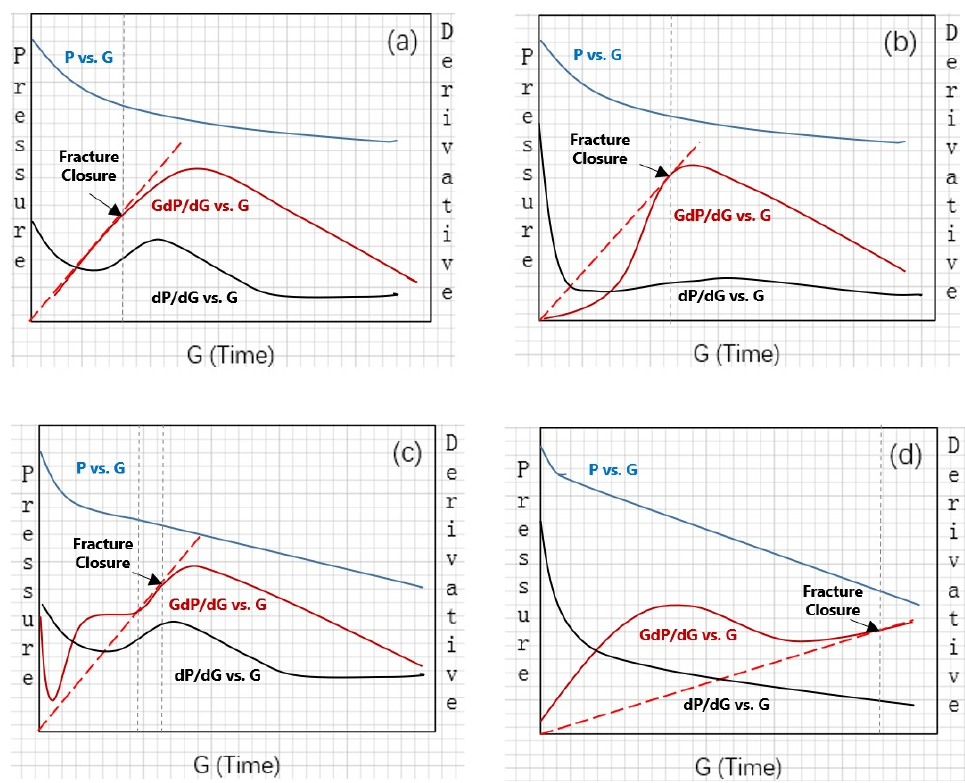
Figure 2. Type of pressure vs. G-function, dP/dG vs. G-function, and GdP/dG vs. G-function trends: ( a ) normal leak-off behavior and ( b ) non-ideal leak-off behavior (I) that depicts a signature of height recession/transverse storage. ( c ) Non-ideal leak-off behavior (II) that depicts a signature of pressure-dependent leak-off behavior, which occurs when the fluid-loss rate varies significantly with the